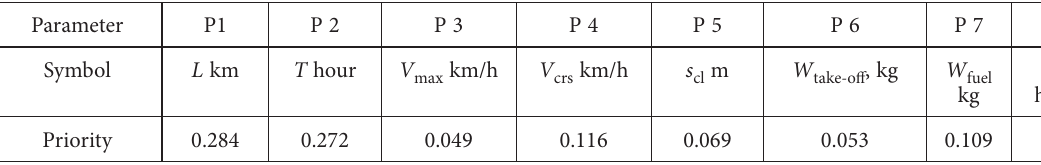
Table 4. Local priorities of parameters Parameter